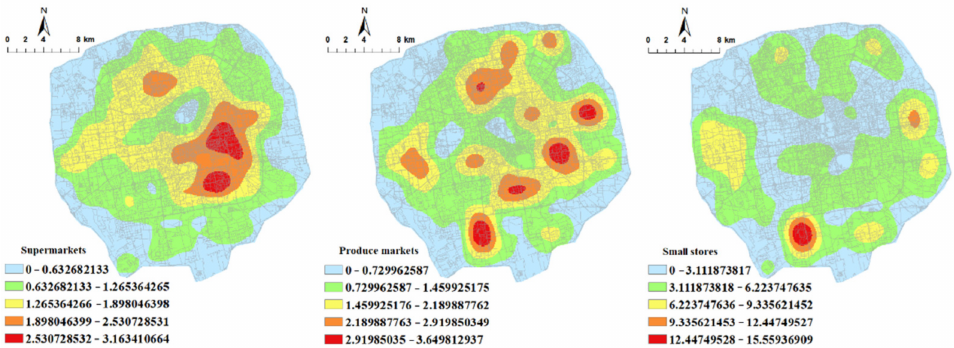
Figure 3. Distribution of kernel density estimation values for the three types of food retail